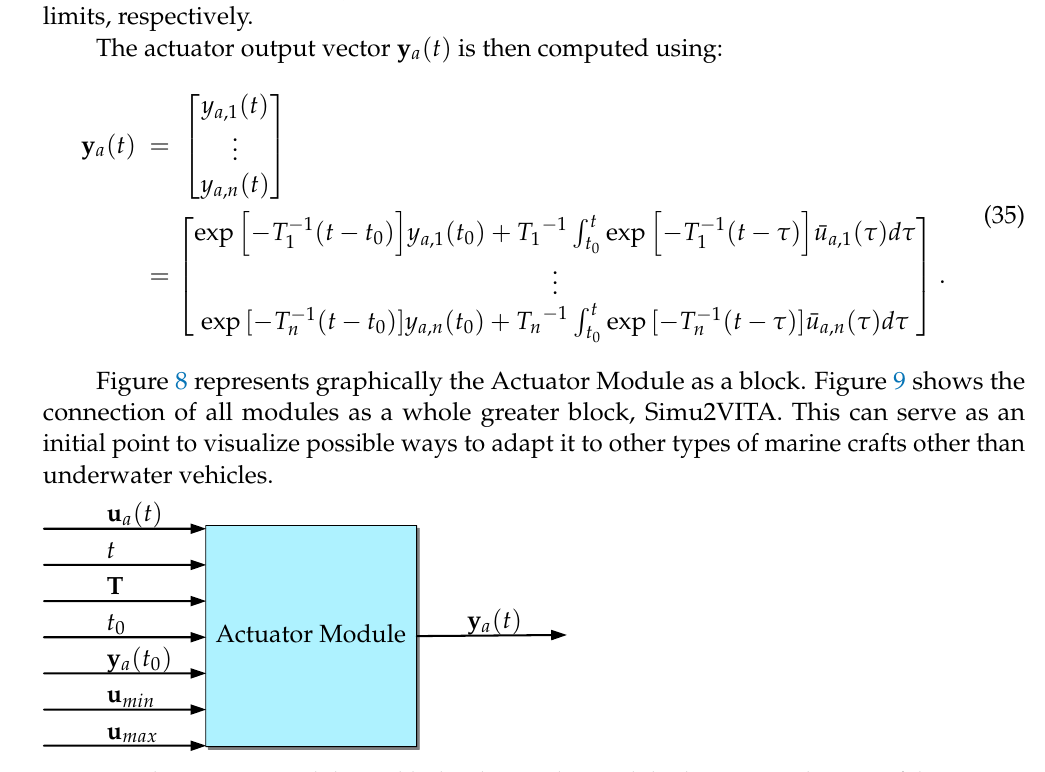
Figure 8. The Actuator Module as a block. Observe this Module also outputs the state of the actuator before it passes through the saturation.